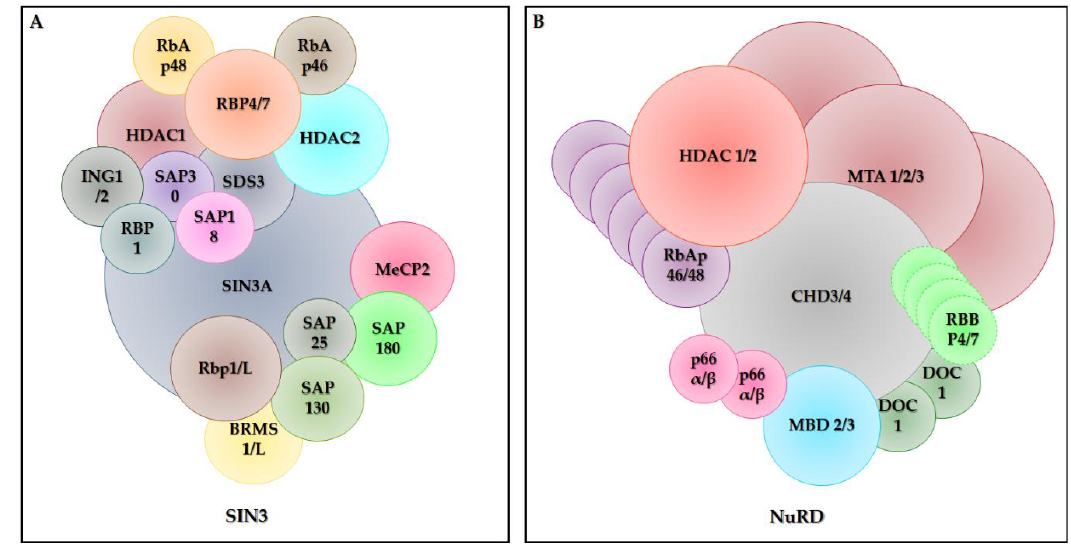
Figure 3. Structure of class I HDAC co-repressor Complexes. HDAC1 and HDAC2 are recruited to the ( A ) SIN3 and the ( B ) NuRD. Adapted from [96,100,115].